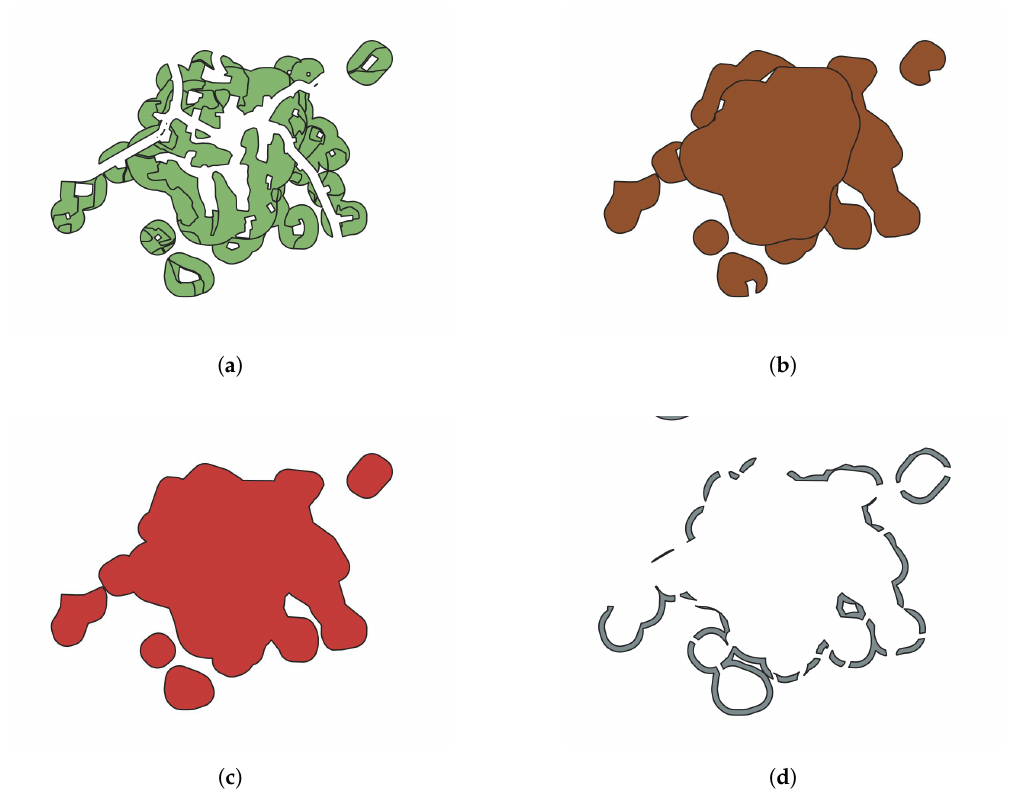
Figure 6. Example of the processing chain to obtain the interior of the Fuel Management Zones (FMZs) around housing. ( a ) Initial FMZ; ( b ) Concave Hull applied; ( c ) Polygon dissolveddissolved, and holes removed; ( d ) Difference between the FMZ with a 20 m buffer and the polygon that represents the interior of the initial FMZ, after removing roads from